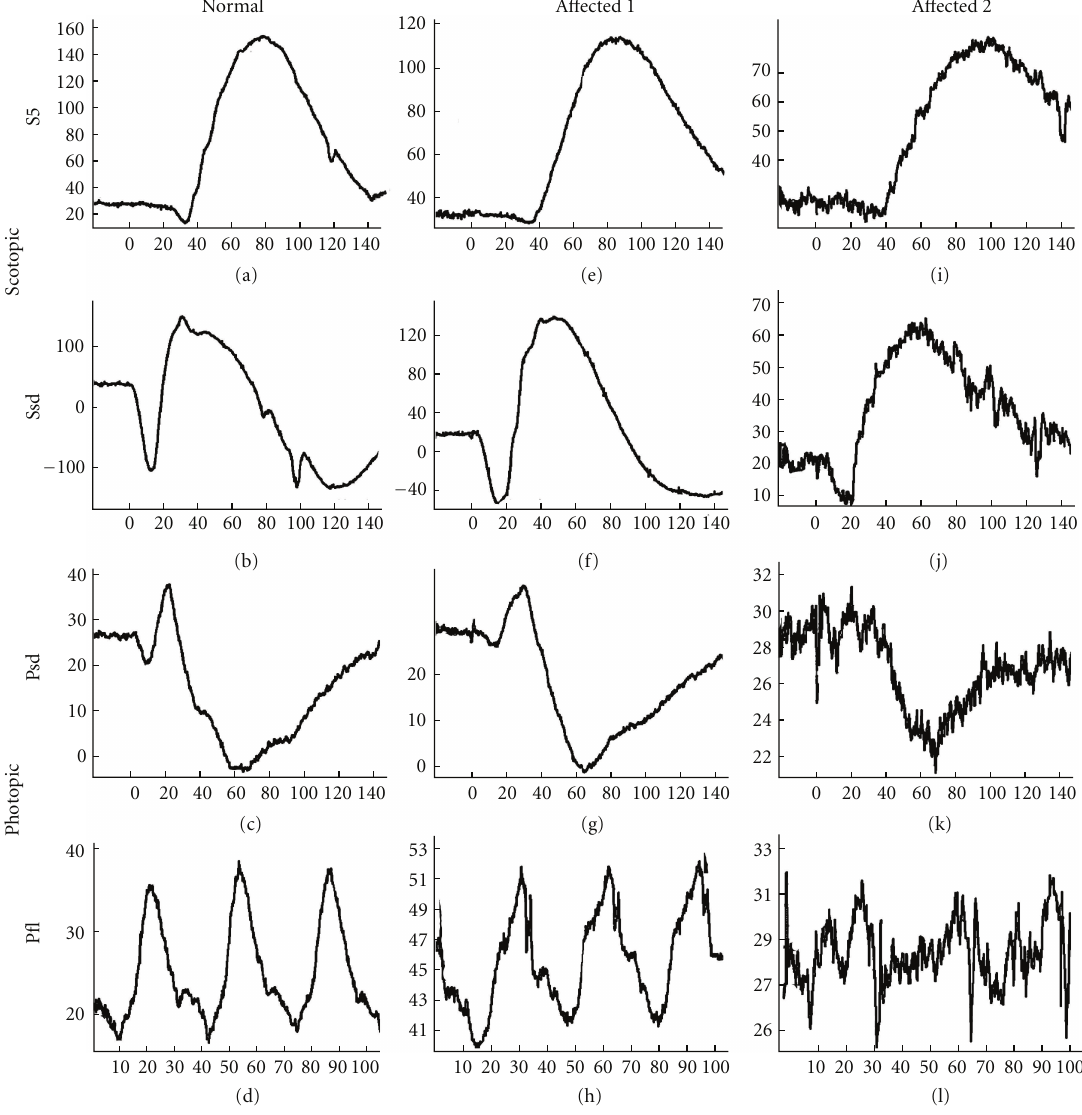
Figure 3: Scotopic and photopic ERGs from a normal 8-year-old ESS dog and two RPGRIP1 − / − a ff ected ESS dogs at the age of 9 (a ff ected 1) and 12 years (a ff ected 2), respectively. The latter a ff ected dog was normal at ophthalmoscopic examination when it was 9 years old. At the age of 12 years it was only slightly visually compromised, and in a moderately advanced stage of retinal degeneration as seen by ophthalmoscopy. S5: scotopic ERG response using 10 mcd · s/m 2 of light stimuli after 20 minutes of dark adaptation, Ssd: scotopic ERG response using 3cd · s/m 2 of light stimuli in the dark, Psd: photopic ERG response using 3cd · s/m 2 in the light after 10 minutes of light adaptation (with 30 cd/m 2 of background light), Pfl: photopic ERG flicker response after 30Hz flickering light stimuli in the light adapted